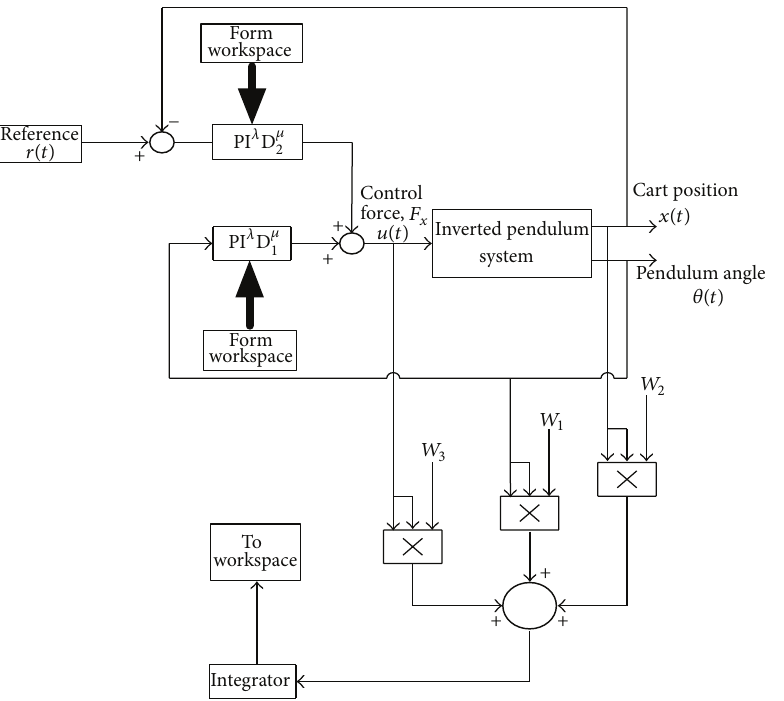
Figure 5: Basic block diagram of closed loop control system using two PI 𝜆 D 𝜇 controllers.